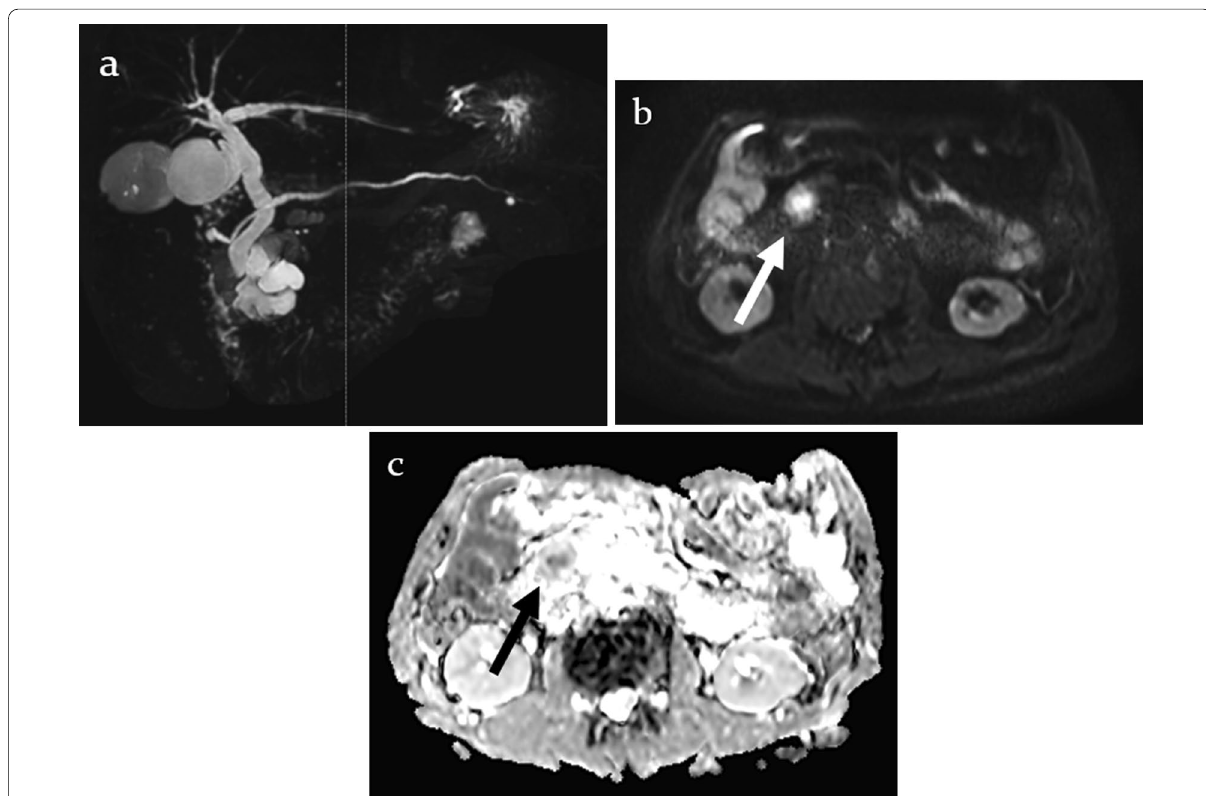
Fig. 2 a Magnetic resonance cholangiopancreatography (MRCP) showed a multilobular cyst in the branch duct with communication between the cystic lesion and the main pancreatic duct. b Diffusion-weighted imaging (DWI) showed an area of hyperintensity in the mural nodule (white arrow). c Apparent diffusion coefficient (ADC) was decreased (black arrow)